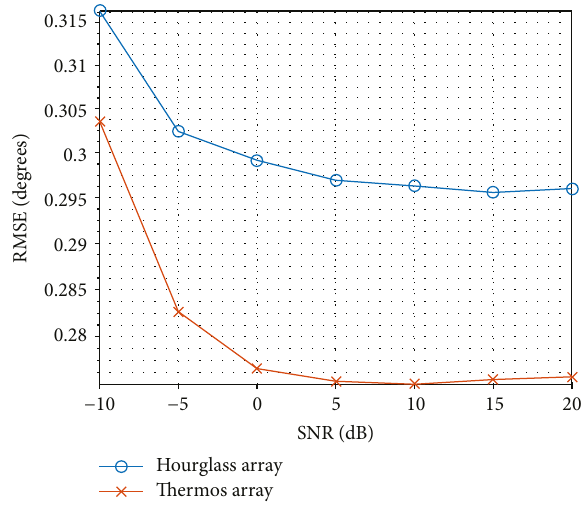
Figure 5: RMSE versus SNR of two array geometries with 1000